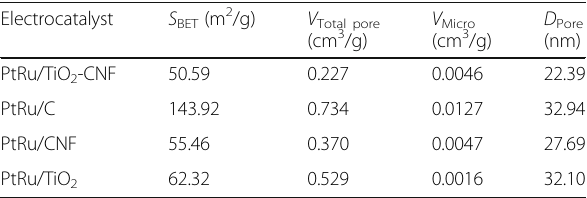
Table 3 BET analysis results for electrocatalyst PtRu/TiO 2 -CNF, PtRu/C, PtRu/CNF, and PtRu/TiO 2 Electrocatalyst